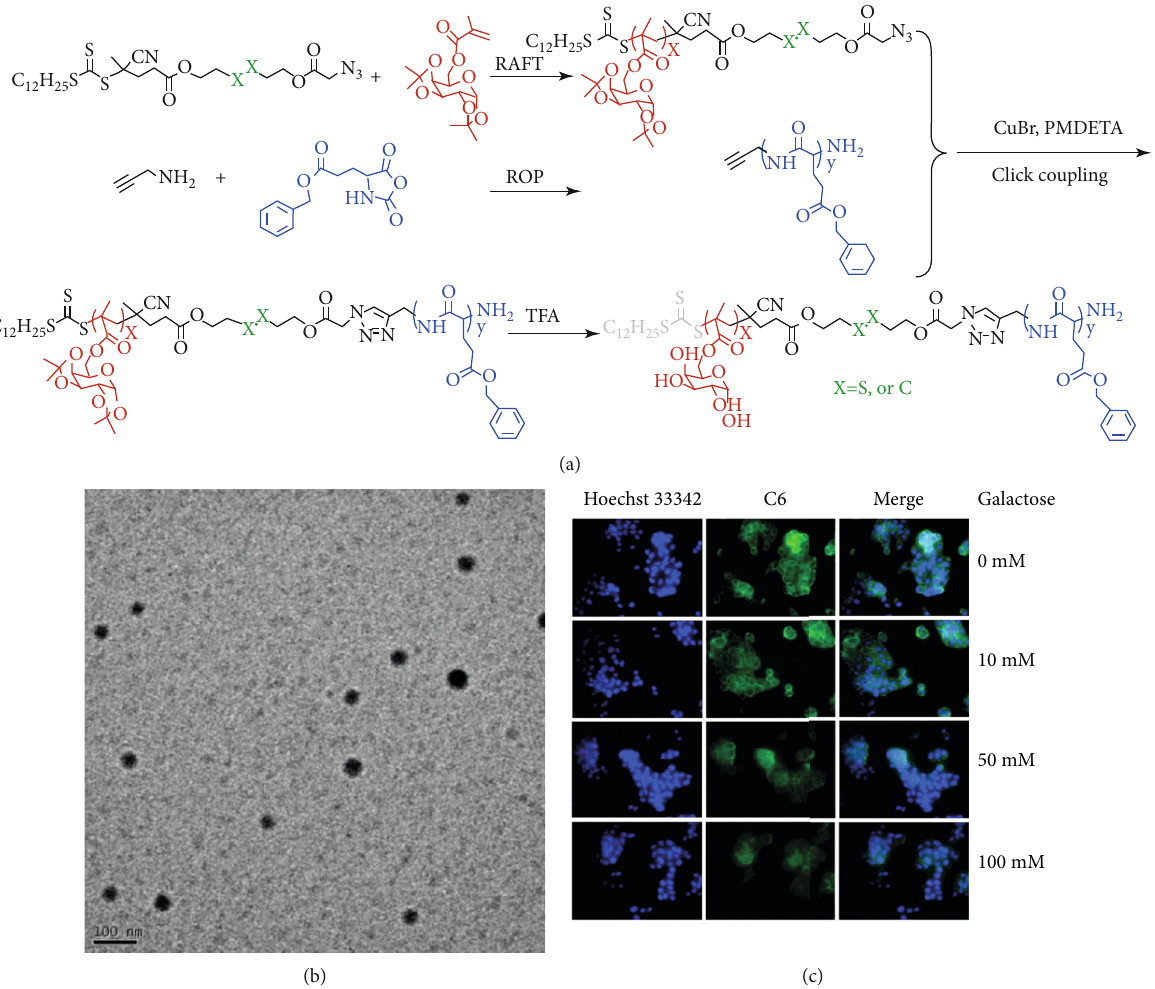
Figure 3: (a) Schematic pathways for the preparation of glycopolypeptide analogues via a combination of RAFT polymerization, NCA ring- opening polymerization, and “ click ” coupling reaction; (b) TEM images for the PMAgala competitive inhibition experiments to show HepG2-targeting e ff ects. Fluorescence microscopic images (400x) of HepG2 cells were pretreated with C6-loaded micelles (100 μ g/mL) under galactose of various